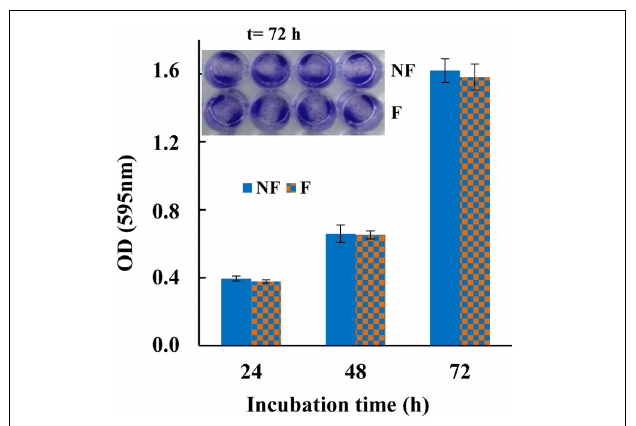
FIGURE 5 | Cytotoxicity of MTP1-PETs on HT-29 cell line measured with crystal violet at 24, 48, and 72 h incubation. The data are shown as means ± s.d. of two separate experiments performed in quadruplicate. Insert: HT-29 cell line after staining with crystal violet incubated with MTP1-PET (F) for 72 h. Not-functionalized disks were used as control